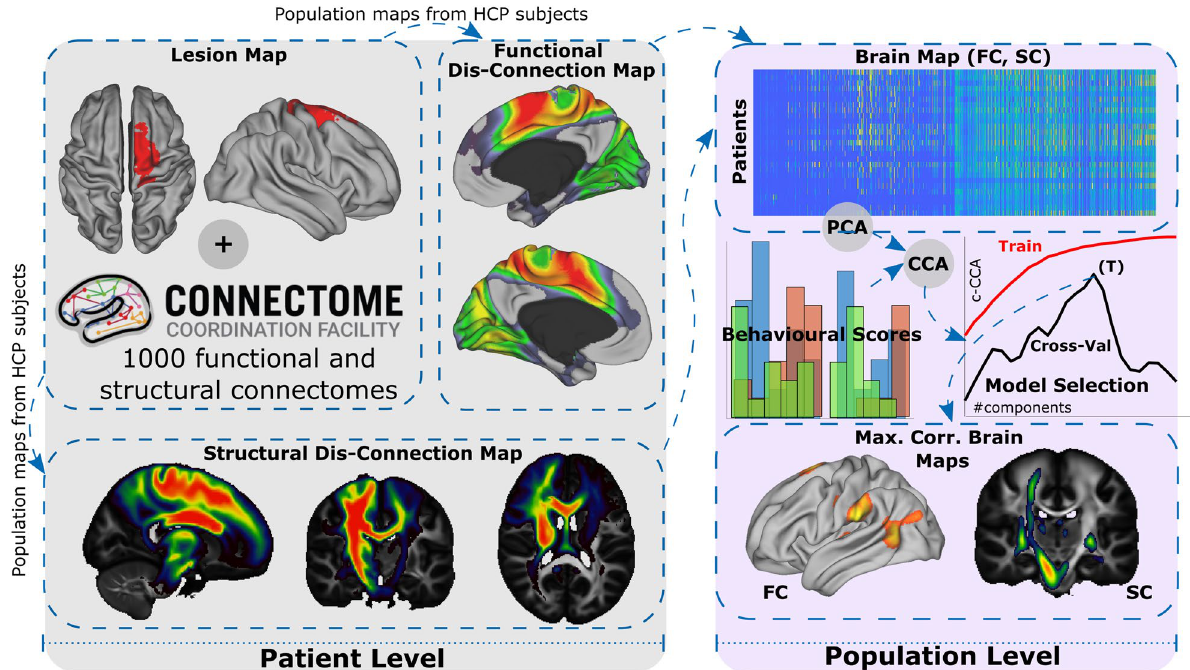
Figure 1. Pipeline for multimodal and multidomain lesion network mapping and its association to behavioral outcome after stroke through Canonical Correlation Analysis (CCA). At the patient level (gray shading), brain lesion masks are used as seed regions to calculate the functional correlation maps (applying seed-based correlation analysis and using the segmented lesion as the seed for each HCP subject) and the structural correlation maps (applying tractography from the segmented lesion to the rest of the brain for each HCP subject) from a group of healthy control participants from HCP (N = 1000). After averaging all the participants in the HCP dataset (see Methods for details), we obtained the functional disconnection maps for each patient, accounting for the functional impact of lesion disconnection, and likewise for the structural disconnection maps. At the population level (purple shading), a matrix with dimensions (# of stroke patients) x (# of voxels) per modality map (FC or SC) was built and reduced using a PCA, which returns a new matrix with (# of patients) × (# of principal components) dimensions, the PCA components considered here as the brain map features. The association between the features of the SC and FC, and the behavioral scores was obtained by applying a CCA. As the number of features increases, the correlation between features and behavior (represented here as c-CCA) increases up to values close to 1 (red curve, Train), dealing with overfitting. Cross- validation techniques can overcome this problem (for details see Methods). For the maximum CCA correlation value in the cross-val curve (black), represented by T, we built brain maps of those components producing maximum performance. The maps can be obtained in a single modality, here shown for FC or SC, or as a combination of them (not shown here but implemented in this